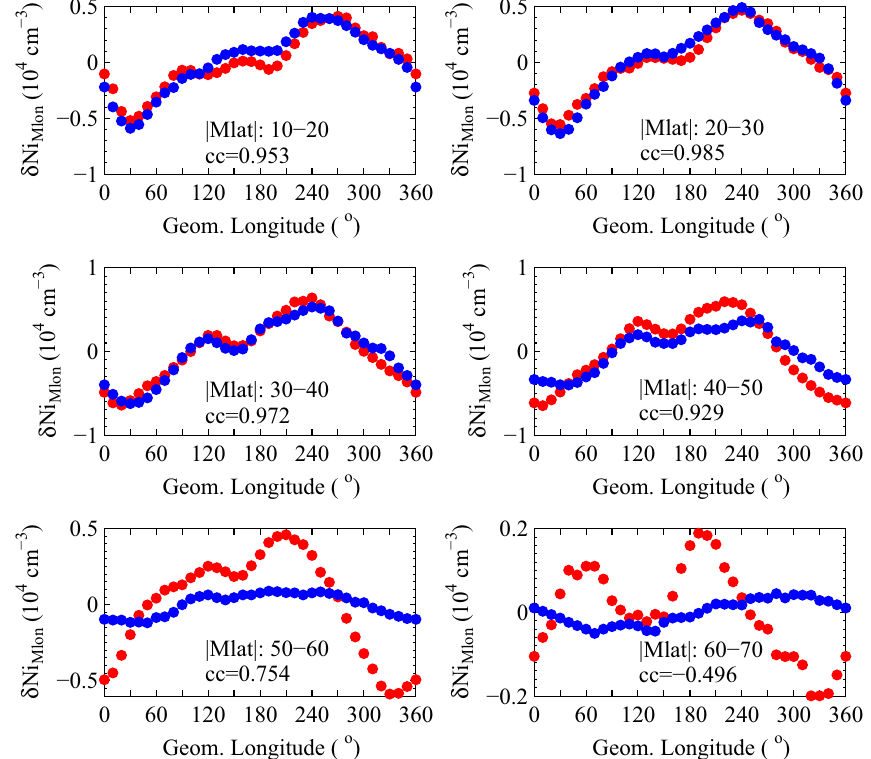
Fig. 2. Longitude fl uctuations of ( d N i ) Mlon calculated from DMSP F12 N i at 21:30 LT around the June Solstice of 1996 for six conjugate geomagnetic latitude bands. The red dots for northern latitude bands and the blue dots for southern latitude bands; cc is the correlation coef fi cient between the red and blue dots.